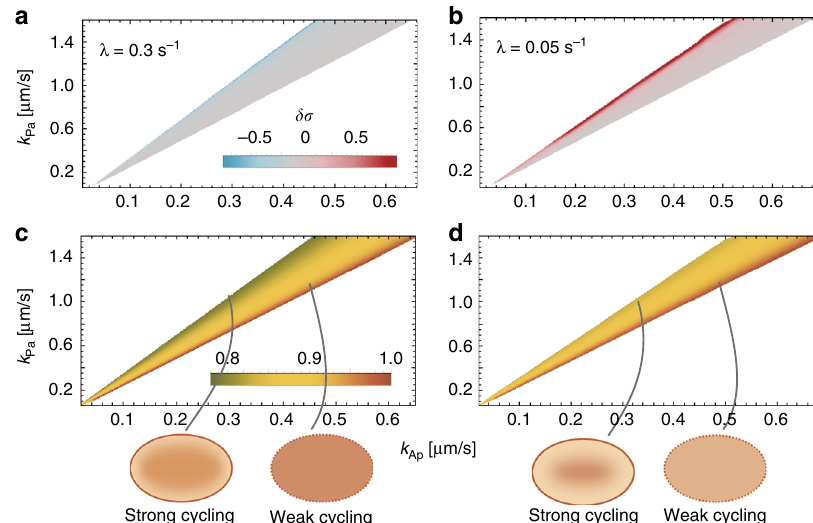
Fig. 4 Role of phosphorylation rates in polarisation and axis selection. Linear stability analysis shows that spontaneous polarisation is possible only within a range of ratios of the phosphorylation rates, k Pa / k Ap (cone-shaped regions): The relative difference in the growth rates of even and odd modes ( δσ ) is shown in ( a ) for λ = 0.3 s − 1 , and ( b ) for λ = 0.05 s − 1 in colour code (indicated in the graph). Panels ( c ) and ( d ) show the corresponding cytosolic concentration of A 1 in the aPAR-dominant unpolarised state ( A 2 has a quantitatively similar concentration gradient to A 1 within the cone, not shown), normalised with respect to the maximal concentration of A 1 obtained within the respective cone. Cartoons at the bottom of the fi gure schematically depict the cytosolic distribution of aPARs throughout the cell. Table 1 Parameters used to create Figs. 3 – 5.